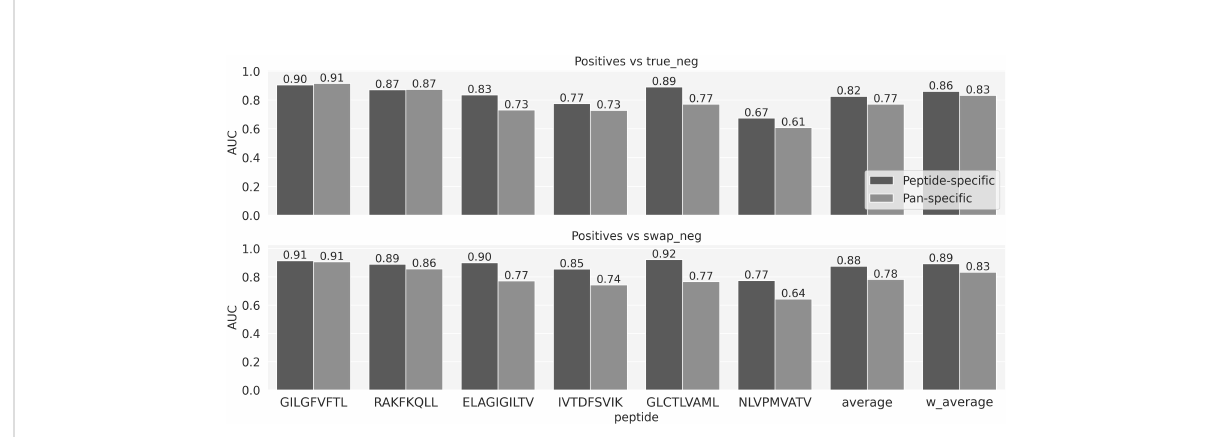
FIGURE 2 The predictive performance for each peptide measured in terms of AUC of the NetTCR architecture based models trained on a - and b -chains and strati fi ed on negative usage and peptide- versus pan-speci fi c approach. Average and w_aveage denotes the average and weighted (by the number of positive TCRs) average AUC over the 6